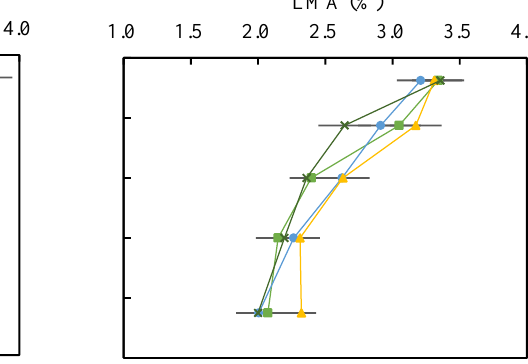
Figure 2. Profile distribution of soil bulk density (BD) and K s at upper slope (UP), middle slope (MP), lower slope (LP), and footslope positions (FP) in sustainable cropland (left) and in conven- tional cropland (right). K s : saturated hydraulic conductivity. The error bars are two standard errors of the means. ** indicates that the difference among different slope positions is significant at p < 0.05. 3.2. Effect of Slope Position and Cropland Management on Water-Stable Aggregates Averaged across all sources of variation, small macroaggregate (0.25 – 2 mm) domi- nated the soil mass in the study region, with a proportion of 66% (62 – 69%), while large macroaggregate (>2 mm), microaggregate (0.053 – 2 mm), and silt + clay fraction (<0.053 mm) accounted for 3% (2 – 4%), 19% (16 – 21%), and 12% (9 – 16%) of the soil mass, respec- tively. The proportion of small macroaggregate significantly increased from the upper slope position to the lower slope position and footslope position in the two cropland man- agement systems. Furthermore, the proportion of small macroaggregate was highest at the footslope position in sustainable cropland and lower slope position in the conven- tional cropland, respectively (Figure 3). The proportion of microaggregate decreased from the upper slope position to the lower slope position in the two cropland systems (Figure 3). Moreover, microaggregate at the footslope position was lower than the upper slope position but was greater than those at the middle slope and lower slope positions in the sustainable cropland, while microaggregate at the footslope position was lower than the upper slope position but was greater than that only at the lower slope position in the con- ventional cropland (Figure 3). However, the effects of the slope position and cropland managements on large macroaggregate and silt + clay fraction were weak (Figure 3 and Table 1). In addition, the proportion of large macroaggregate, small macroaggregate, and microaggregate averaged for all slope positions were higher but the silt + clay fraction was lower in the sustainable cropland than in the conventional cropland (2.68% in LMA, 66.11% in SMA, 19.38% in MI, 11.75% in SC vs. 2.62%, 65.87%, 19.15%, 12.36%, respec- tively) (Figure 3). However, the difference between the conventional cropland and sus- tainable cropland was not statistically significant.